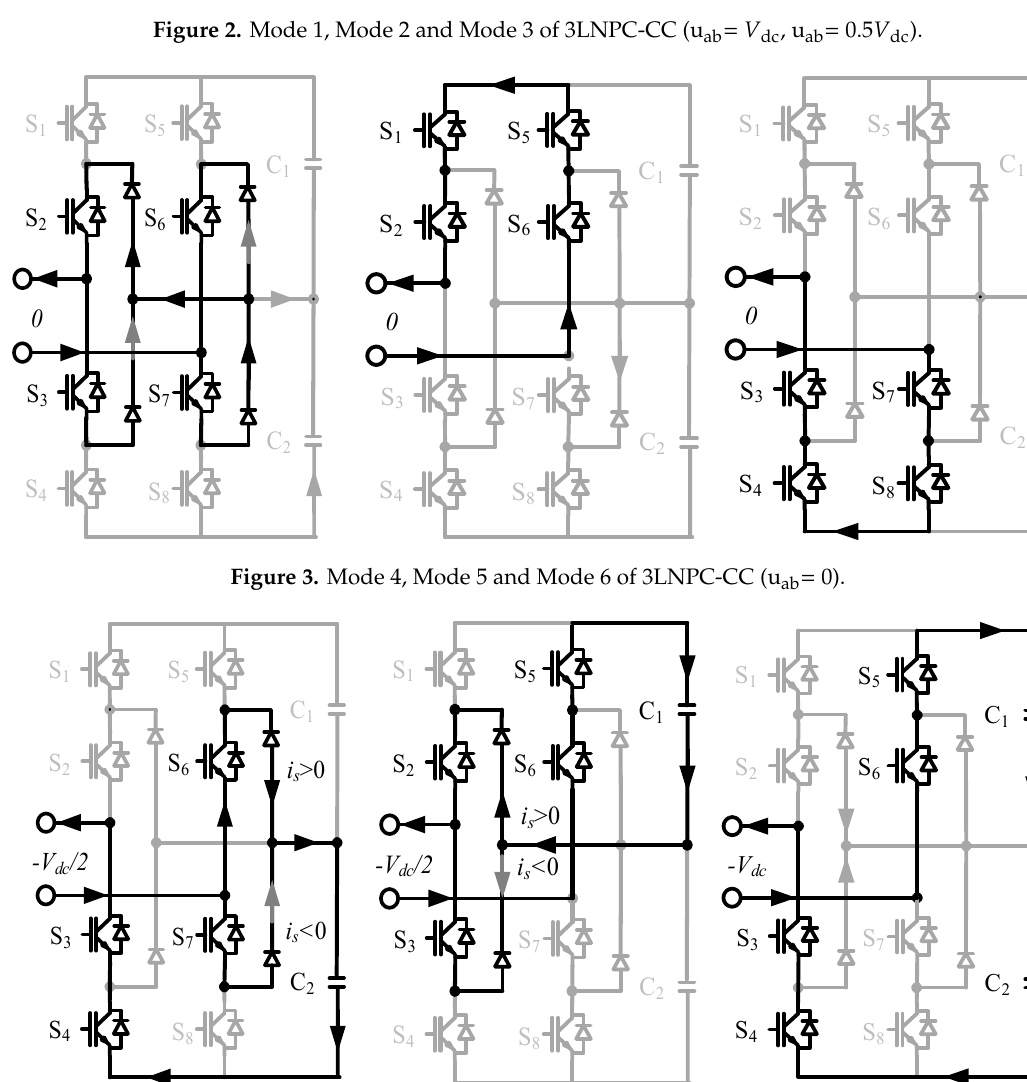
Figure 4. Work state of 3LNPC-CC (u ab = − 0.5 V dc , u ab = − V dc ).